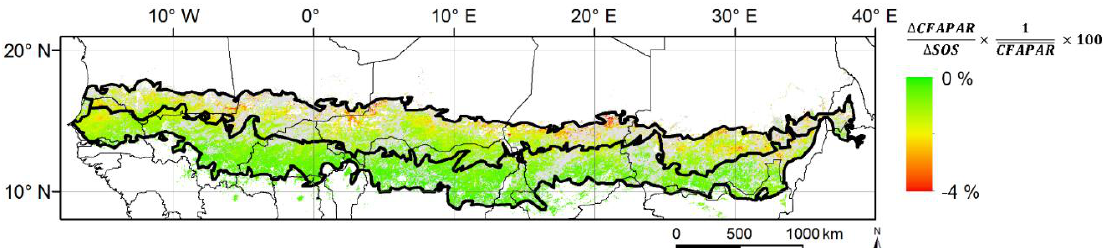
Figure 5. Percentage of variation of the mean seasonal biomass production proxy (CFAPAR) for a one-day anomaly in the timing of SOS. The metric is computed as the slope of the linear regression CFAPAR vs. ΔSOS expressed as a percentage of the pixel-level mean CFAPAR. Pixels where the linear regression is not significant (n.s.) at p = 0.05 are masked in